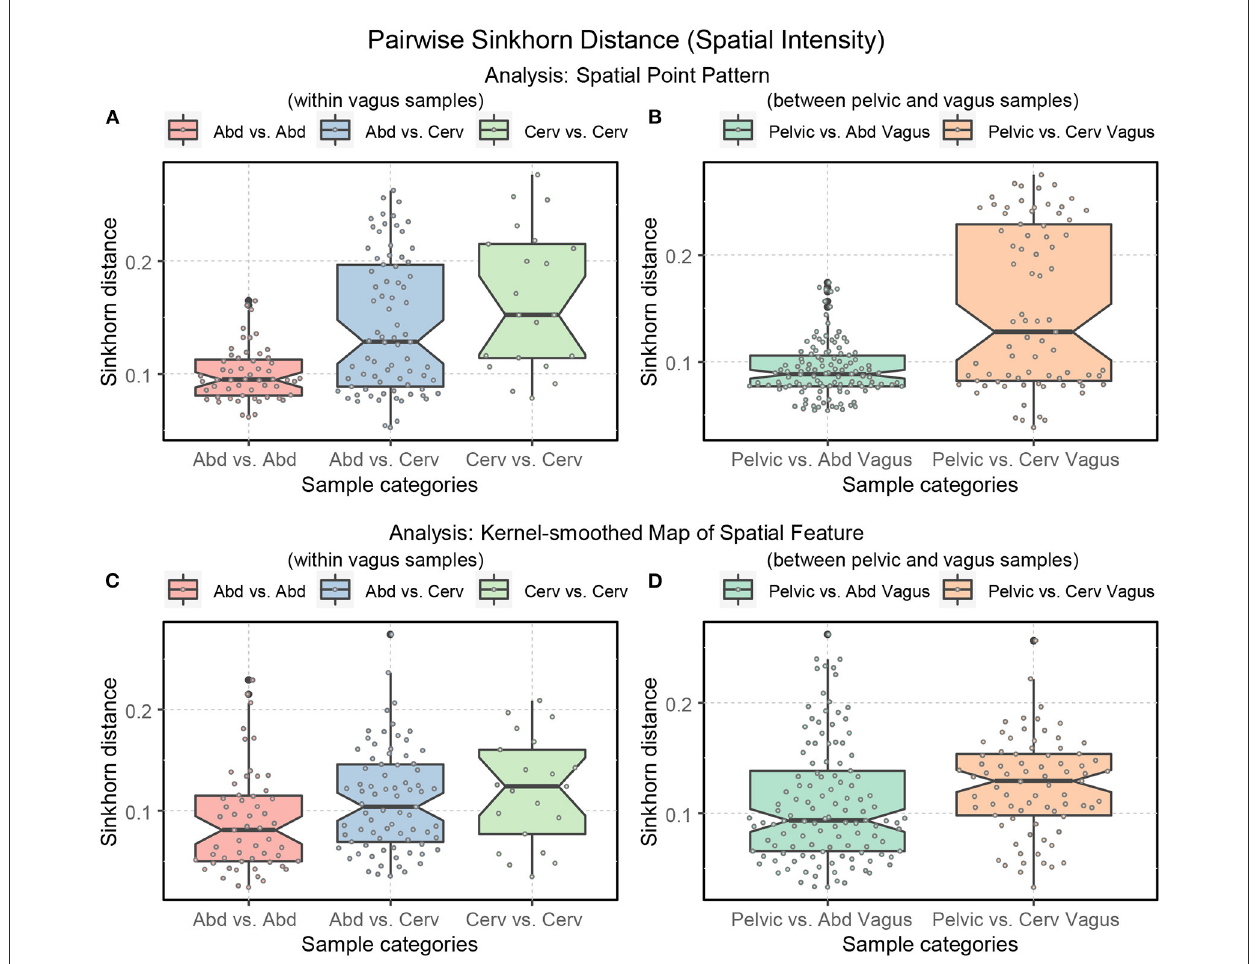
FIGURE14 Boxplots displaying the ranges of Sinkhorn distance between the spatial intensity of the sub-categories of the nerve cross-sections. Abd: abdominal vagus; Cerv: cervical vagus, and pelvic. (A, B) Analysis of the spatial point patterns directly. (C, D) Analysis of the kernel-smoothed maps of the spatial features. The points show the individual Sinkhorn distances, revealing the hidden